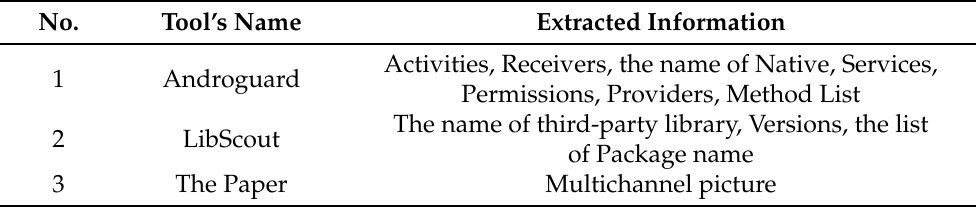
Table 8. The extracted information of Android